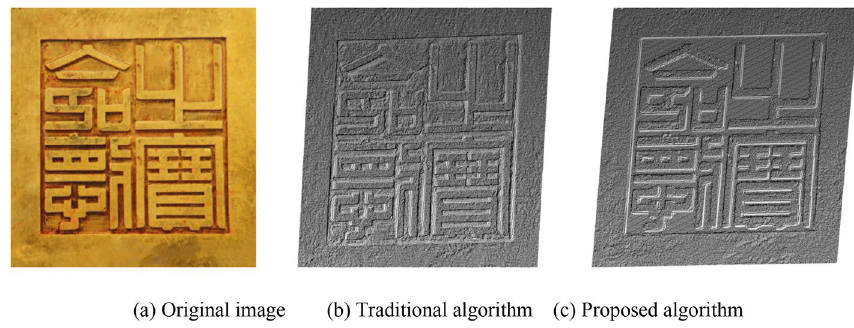
Figure 10. Point cloud comparison images of the “treasure seal”.